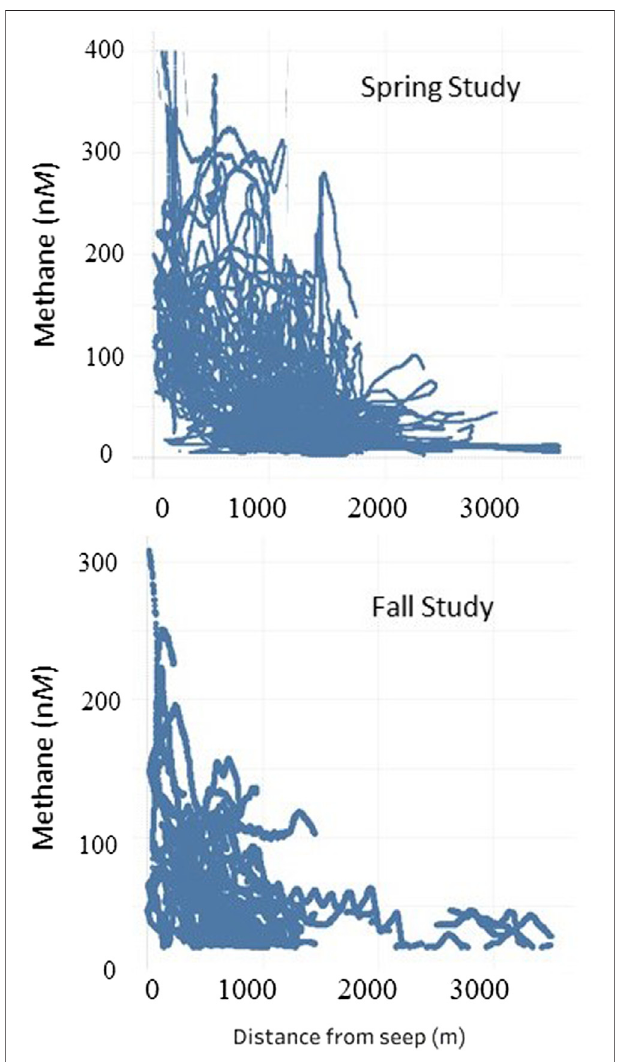
FIGURE 6 | Methane concentrations from all gliders are plotted against the horizontal distance from the seep where the data was collected. The data are fi ltered to include only measurements below 450 m water depth. The spring study data is at the top.